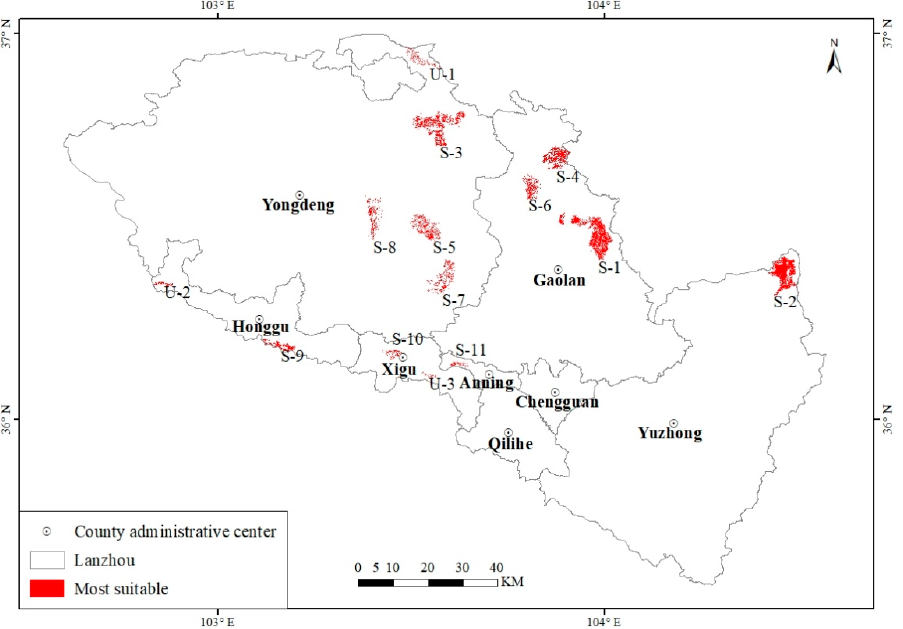
Figure 4. Site selection of MSW landfills in Lanzhou. The red areas were the most suitable landfill sites, with a total of 11 candidate sites selected.